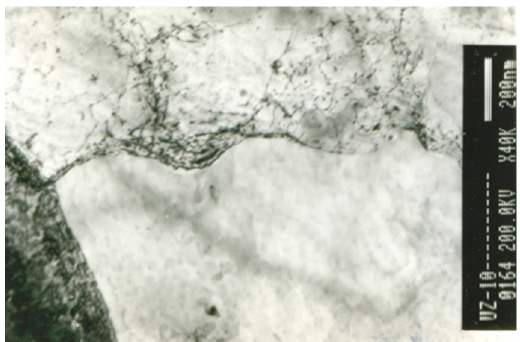
Figure 9. TEM micrograph of dislocations accumulating on the rows of precipitations.